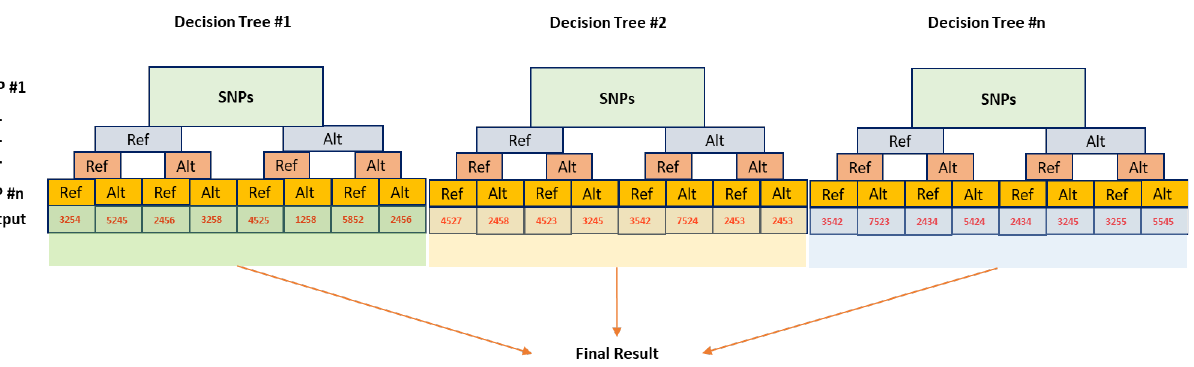
Figure 3. Schematic illustration of random forest used for predicting output (yield as an example) using SNPs dataset. In this case, molecular genetic markers, i.e., SNPs, are input variables, and yield is considered as an output variable. Alternative and reference alleles are expressed as Alt and Ref, respectively. This figure was created using Excel, Microsoft O ffice 2021.